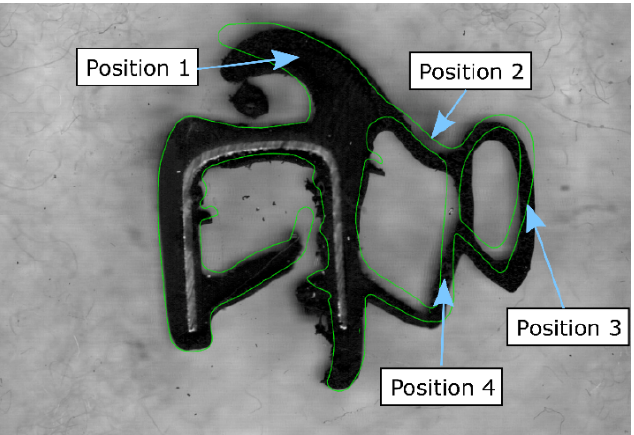
product (black section) and the FEM results (green